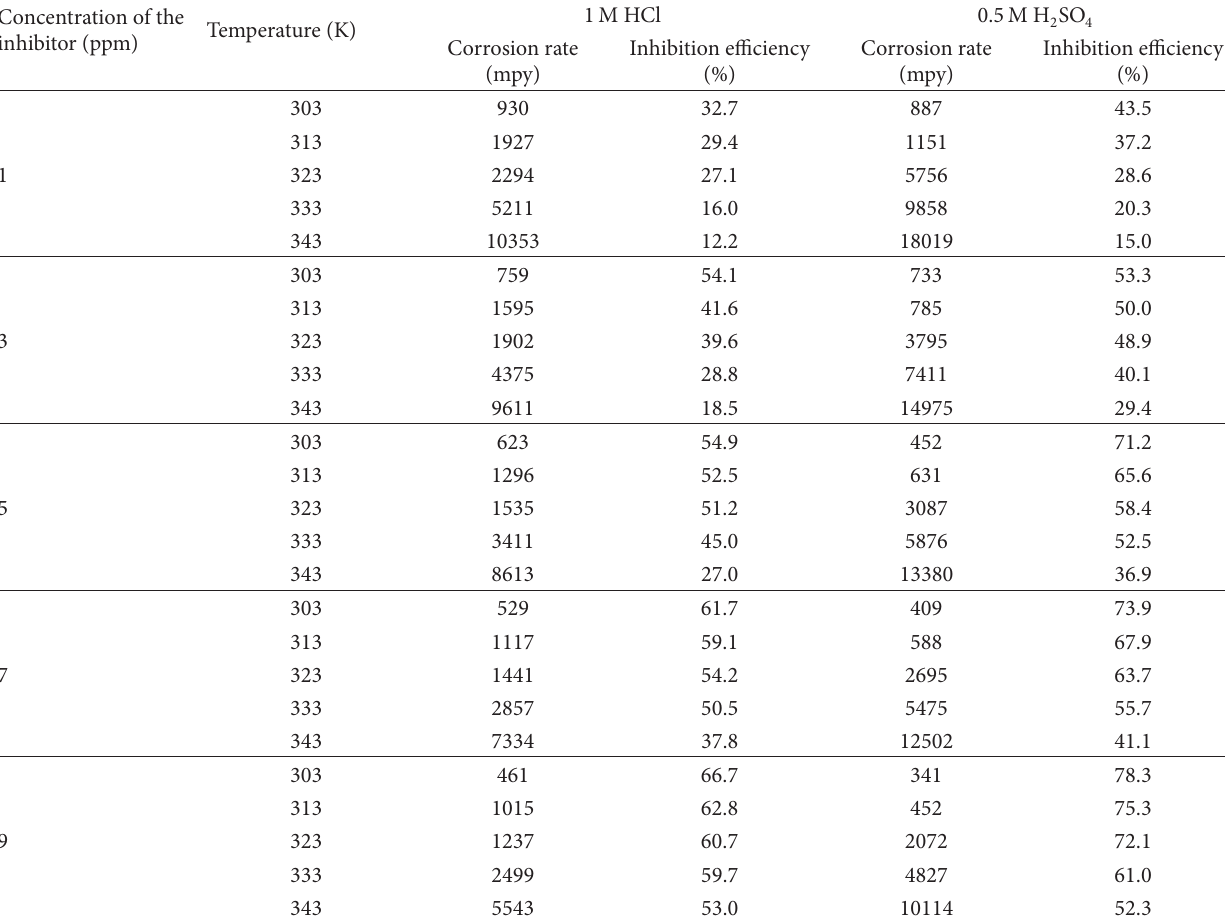
T 2: Inhibition efficiencies of inhibitor for the corrosion of mild steel obtained by weight loss measurements at various temperatures. Concentration of the inhibitor